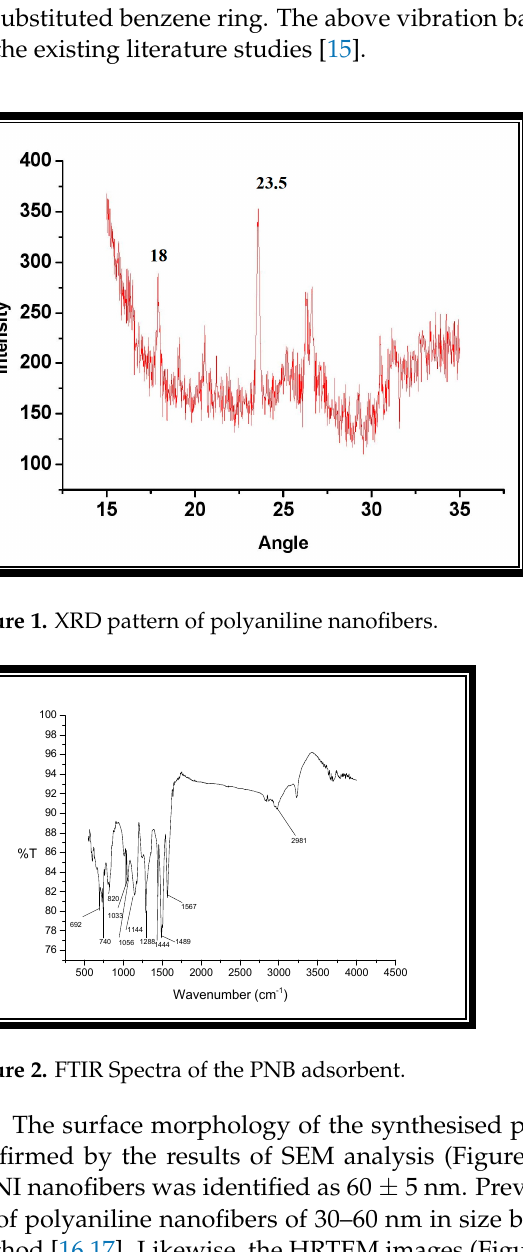
Figure 2. FTIR Spectra of the PNB adsorbent.